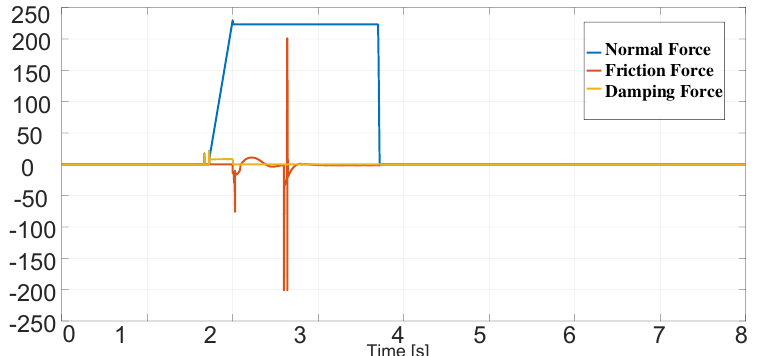
Figure 10. Configurations of the first and second joints.